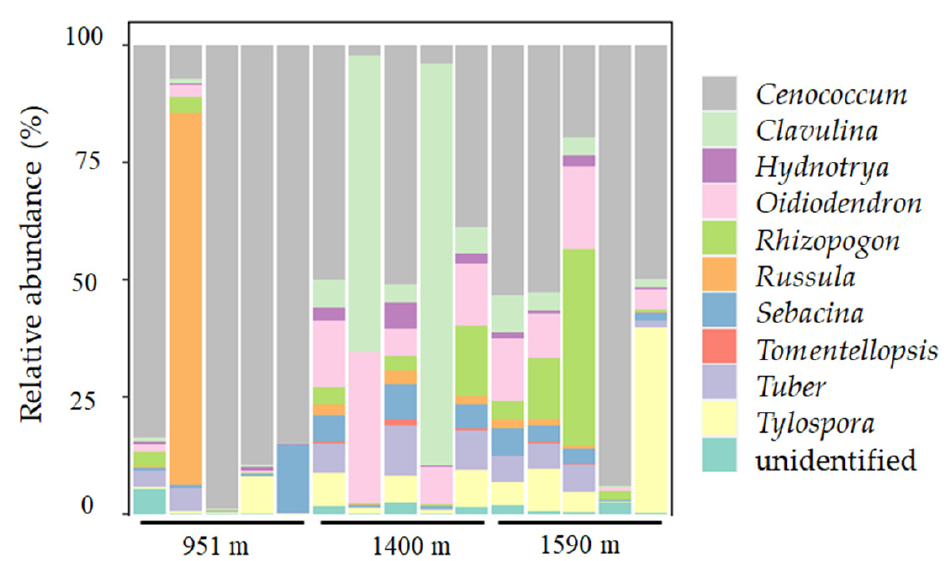
Figure A2. Relative abundances of ectomycorrhizal fungi species (genus level) on resident Abies beshanzuensis tree roots as detected by molecular analysis.